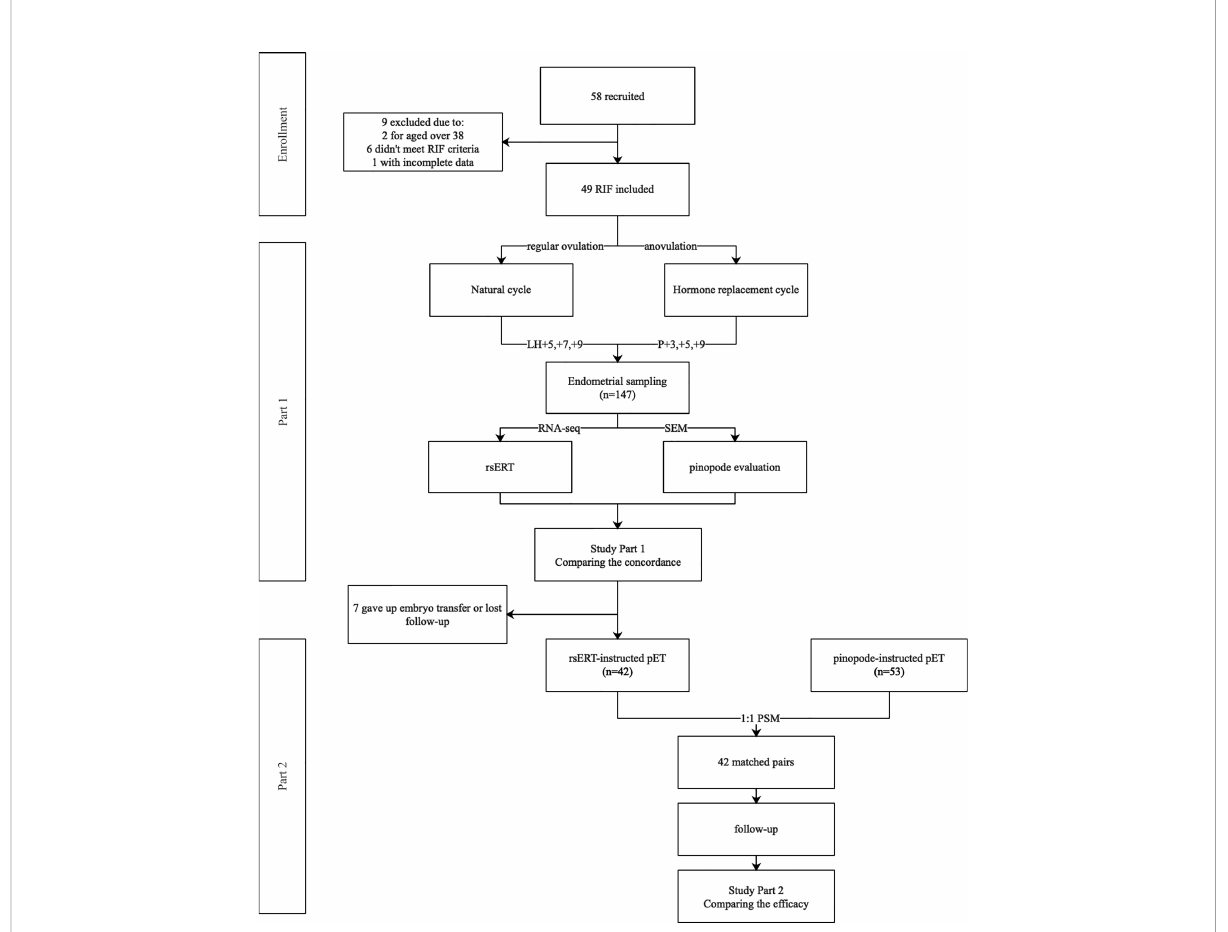
FIGURE 1 Flow chart of the study. A total of 58 RIF patients were recruited in Part 1 of the study, 9 were removed due to variant of reasons. Three consecutive endometrial biopsies from a same menstrual cycle were obtained from each patient, being sent for both rsERT test and pinopode evaluation, and the concordance was evaluated. In Part 2, 42 patients that received rsERT instructed pET were matched with 42 patients who once received pinopode-instructed pET in our center by using PSM in a 1:1 ratio. Clinical outcomes were followed up to compare the ef fi cacy of the diagnostic